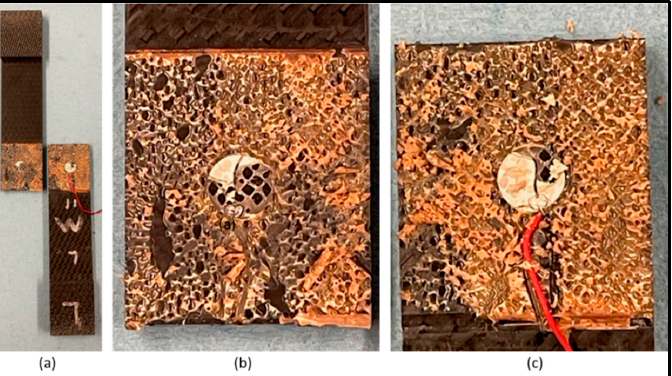
Figure 17. Coupon 11 cohesive failure photos with broken sensor disk. ( a ) Both adherends, ( b ) top adherend, ( c ) bottom adherend.